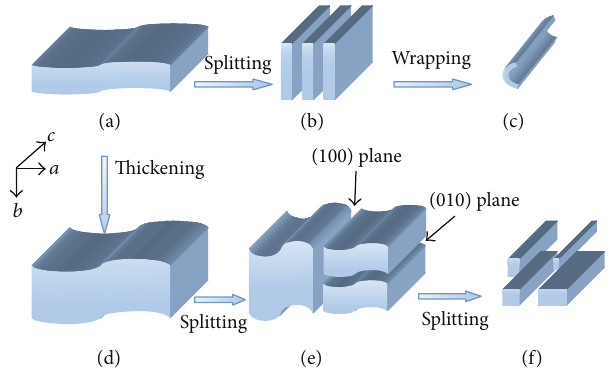
Figure 8: Nanotube/nanorod formation